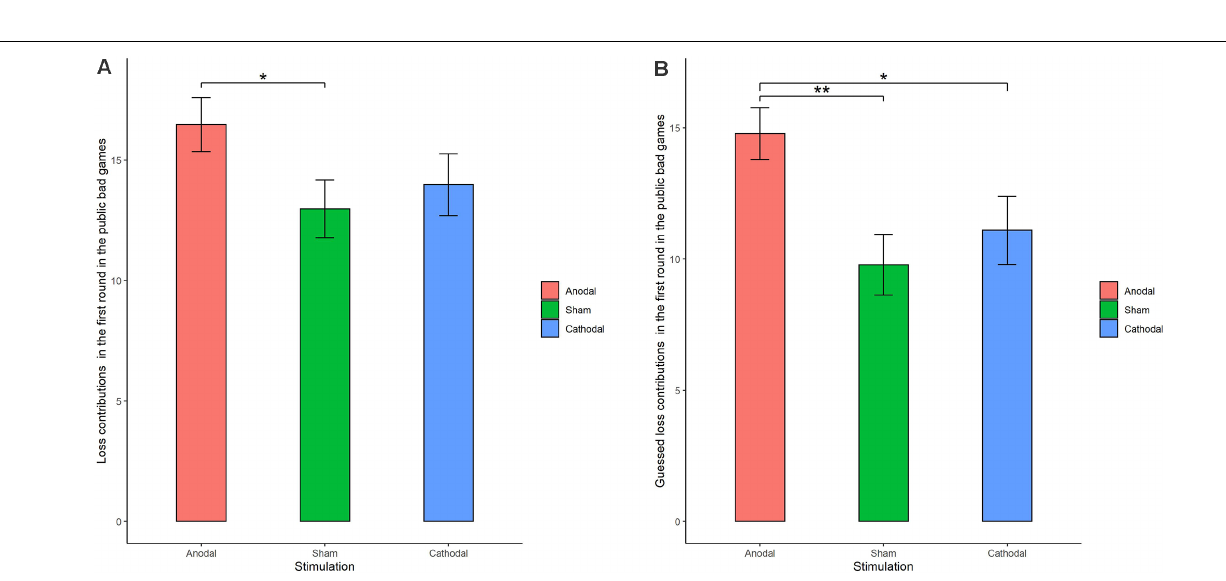
FIGURE 6 | Real contributions (A) and guessed contributions (B) in the first round for public bad games in three stimulation conditions. Error bar represents standard error. * p < 0.05, ** p <